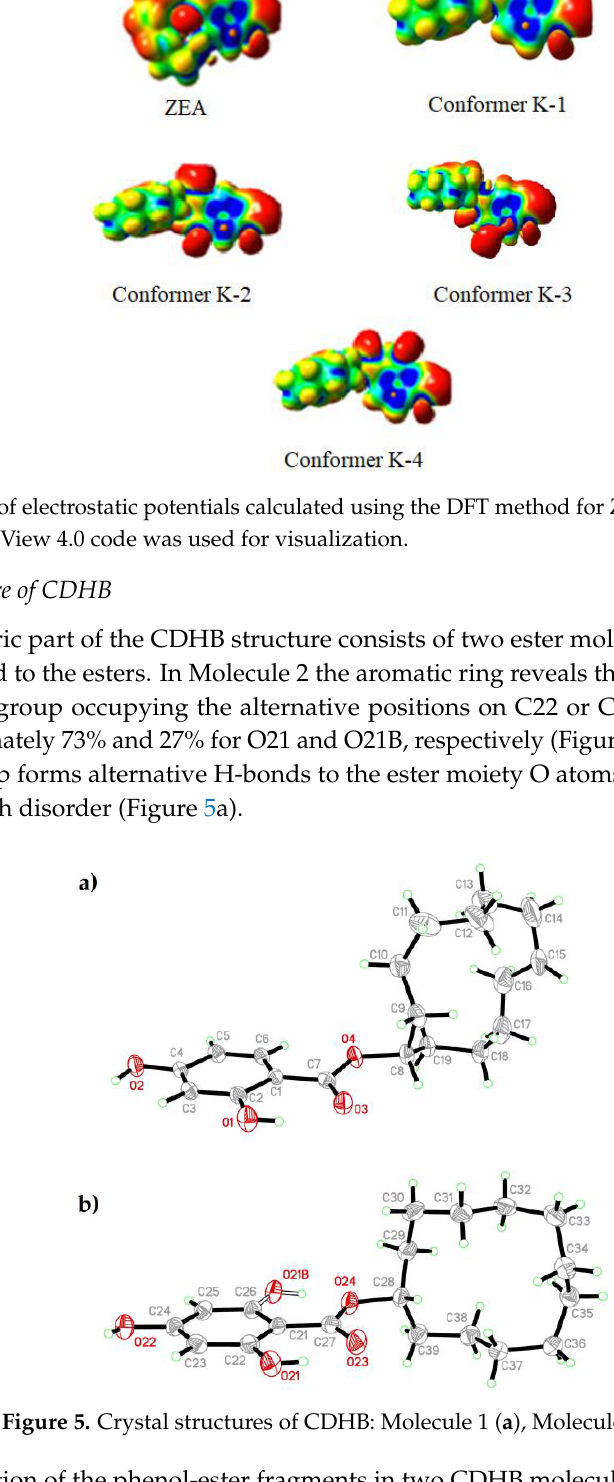
Figure 3. Possible shapes of cavities formed by different conformers of CDHB.